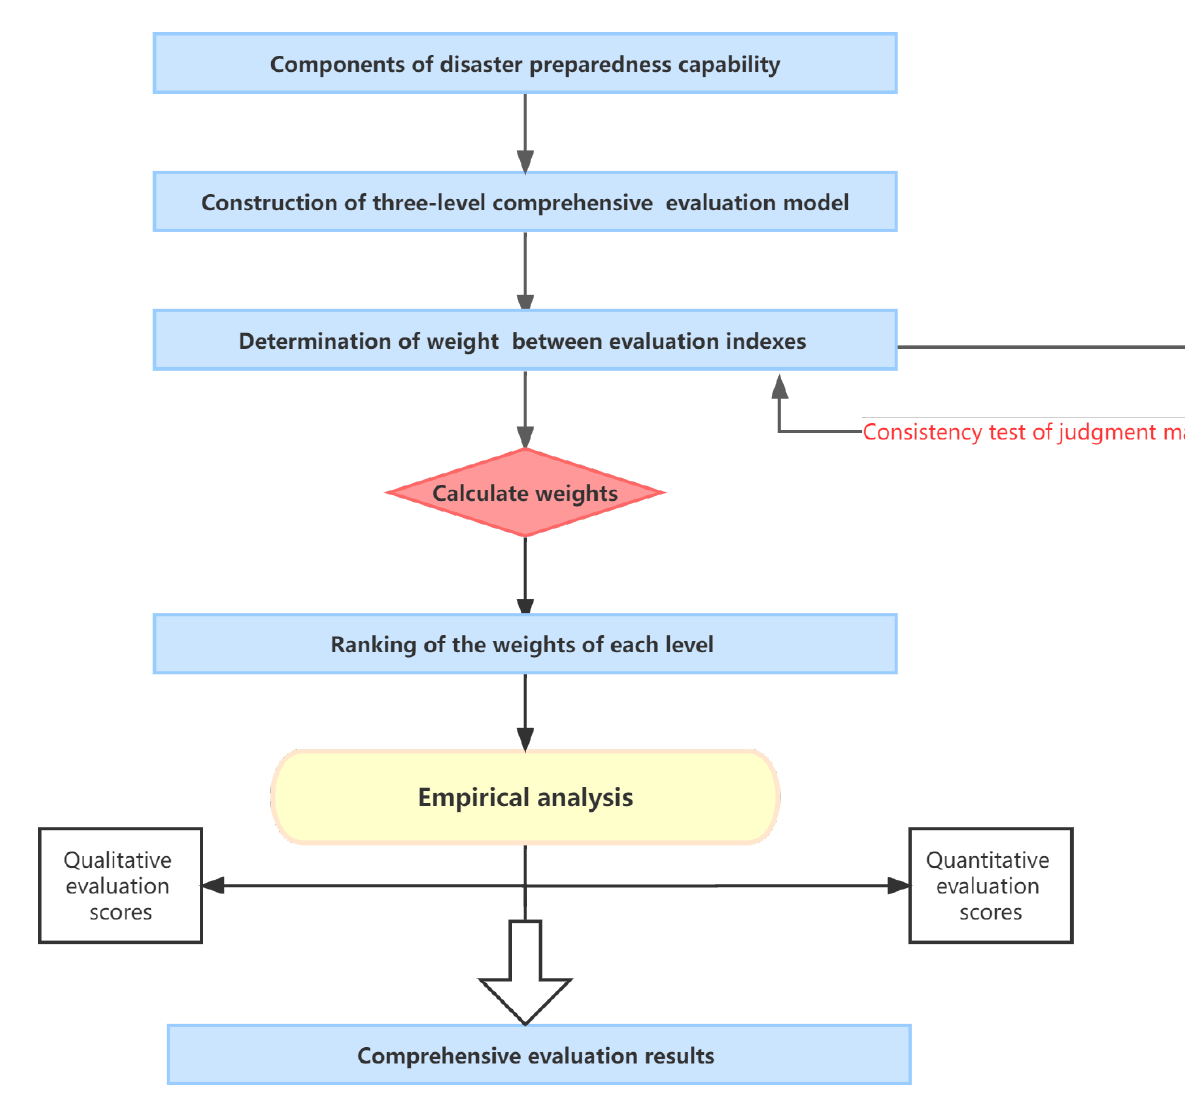
Figure 2. Calculation process